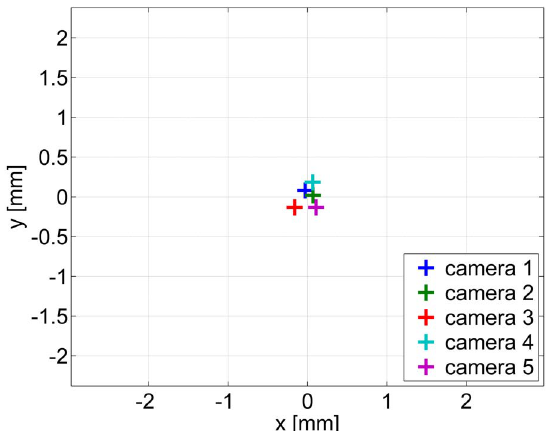
Figure 6: Differences of principal point of investigated identical CREVIS